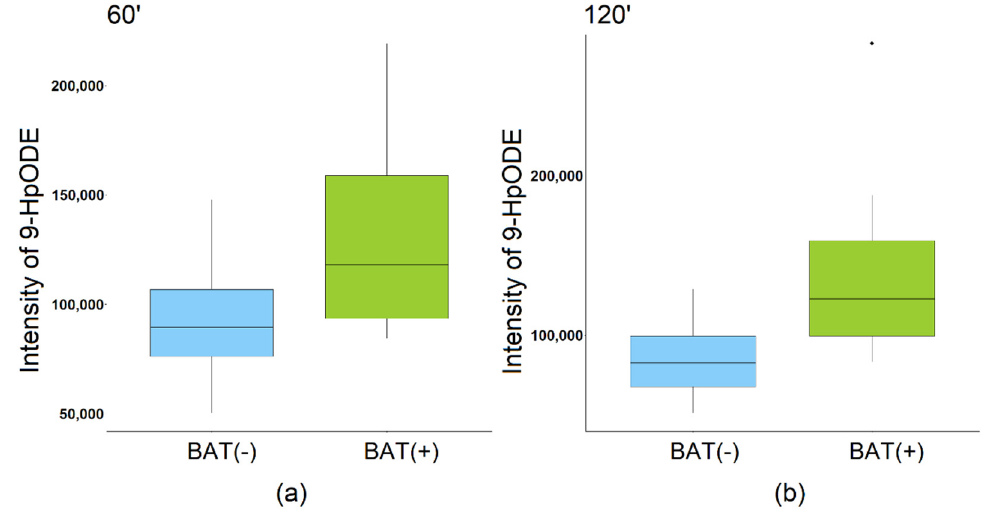
Figure 4. Intensity of 9-HpODE: ( a ) 60th minute of CE; ( b ) 120th minute of CE.